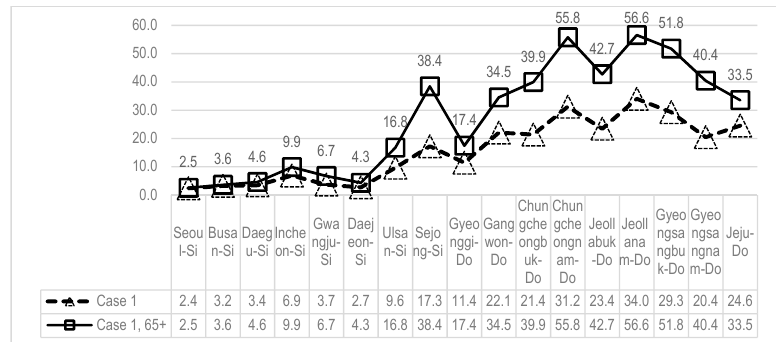
Figure 5. Proportion of the people with LFA by upper-level administrative district (unit: %).